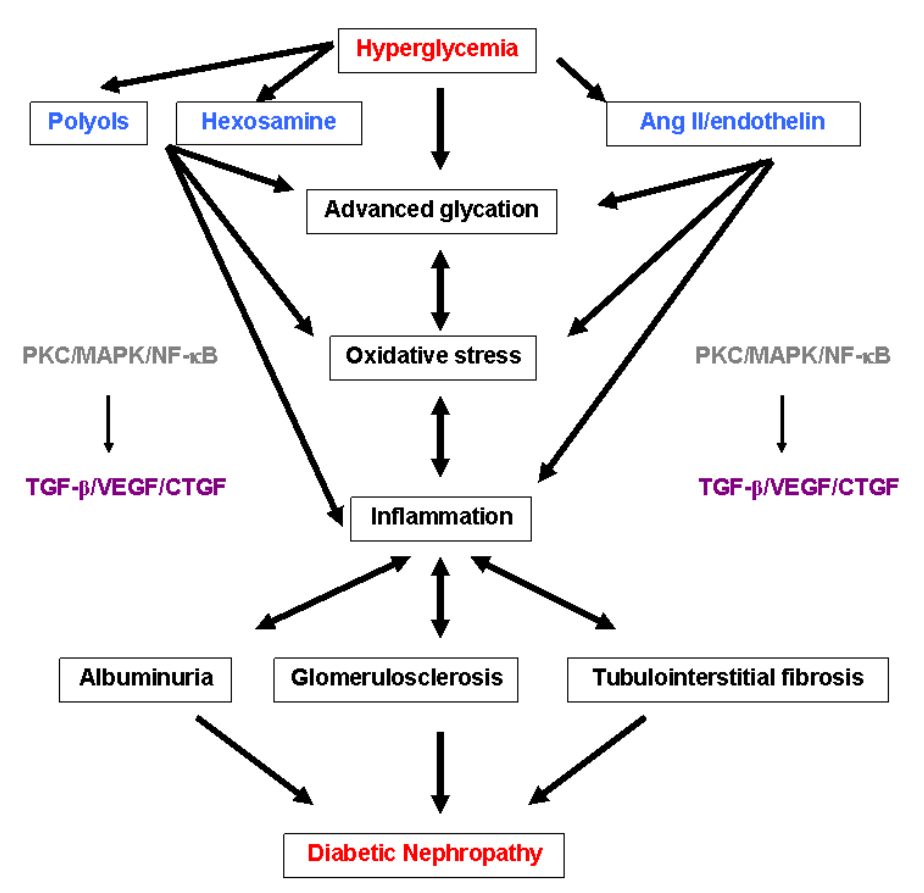
FIGURE 1. Interaction between metabolic and hemodynamic pathways in the pathophysiology of diabetic